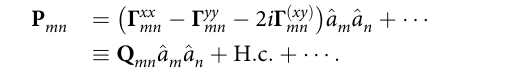
Fig. 2 Characterization of instability. a Complex energy of the edge eigenmodes ( cf . Eq. (3)). The real part (frequency) is plotted in blue, whereas the imaginary part (ampli fi cation) is shown in yellow. The perfectly matching grey curve is the theory Eq. (3) with E ¼ g ω ′′ : 3605 J (numerically extracted from band structure, not fi tted to instability). Note that the excellent agreement only holds if the polarization of the π ’ 0 electric fi eld points along y , i.e., along the width of the strip, as we explain in more detail in Supplementary Note 4. b The steady-state edge occupation calculated from Eq. (8) with the same parameters as in Fig. 1 and nonlinear damping η = 10 − 5 J (the same in microscopic theory and chiral waveguide model). Shown in blue is the chiral waveguide model, the yellow dots are calculated numerically from the microscopic Hamiltonian. Parameters are as in Fig. 1, but with W